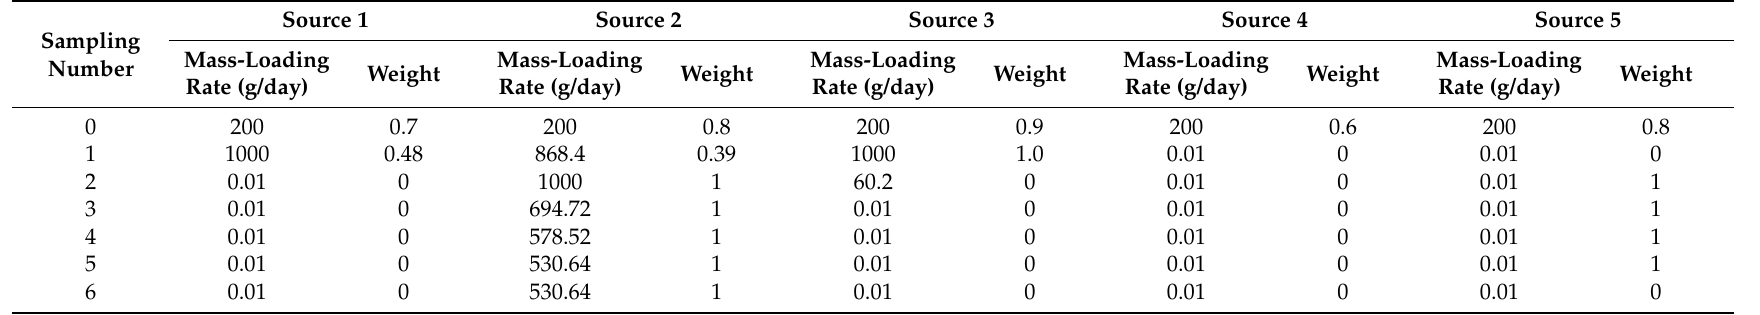
Table 2. Pollution source identification